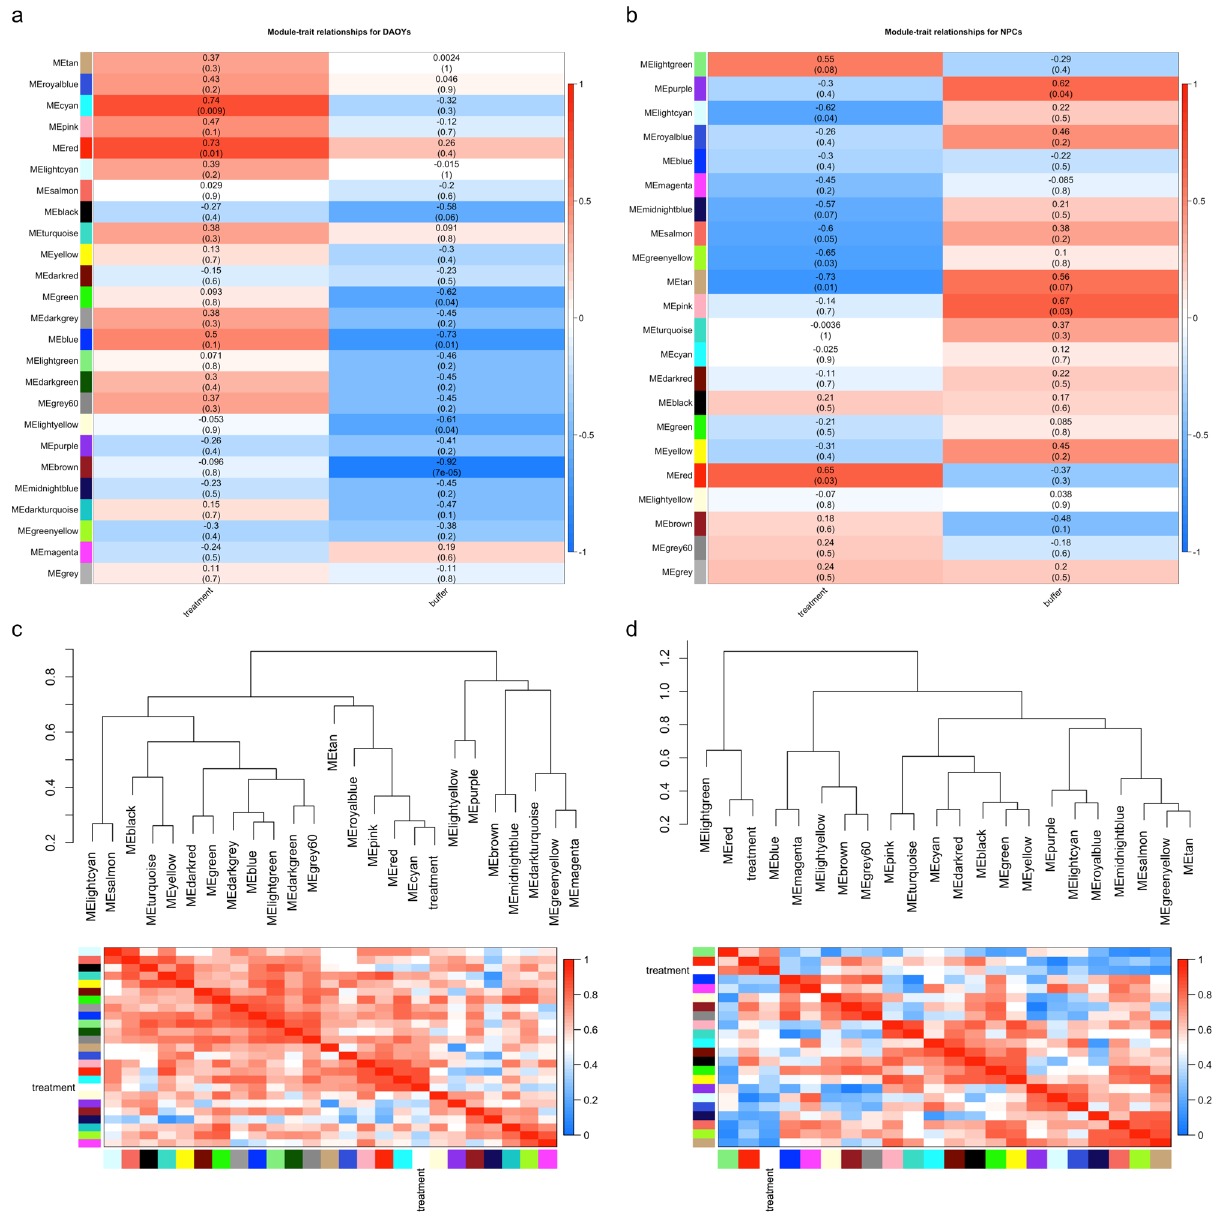
Fig. 2 Co-expression gene modules for convergent propranolol and primidone targets. a Module-treatment (propranolol/primidone) and -buffer (H2O/DMSO; control) correlation heatmaps for DAOYs. b Module-treatment (propranolol/primidone) and -buffer (H2O/DMSO; control) correlation heatmaps for NPCs. Value indicates correlation between gene-trait and gene-module associations with p value in parenthesis. c Module dendrograms with module membership correlation heatmaps for DAOYs. d Module dendrograms with module membership correlation heatmaps for